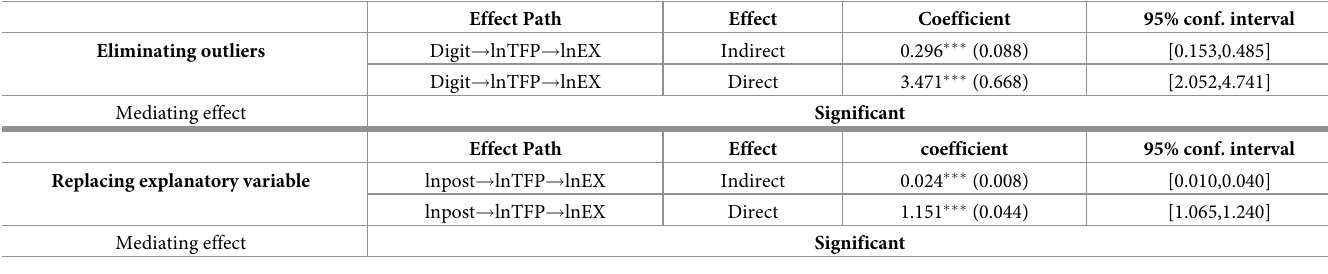
Table 7. Results of the robustness of mediation